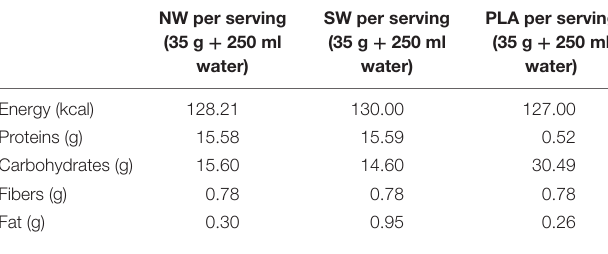
TABLE 2 | Composition of the supplements.